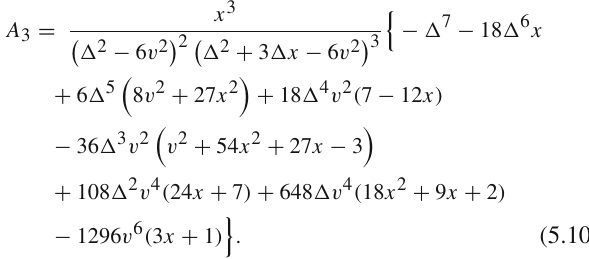
x ( x − 1 − v 2 ) < 0 where the integrating out 4